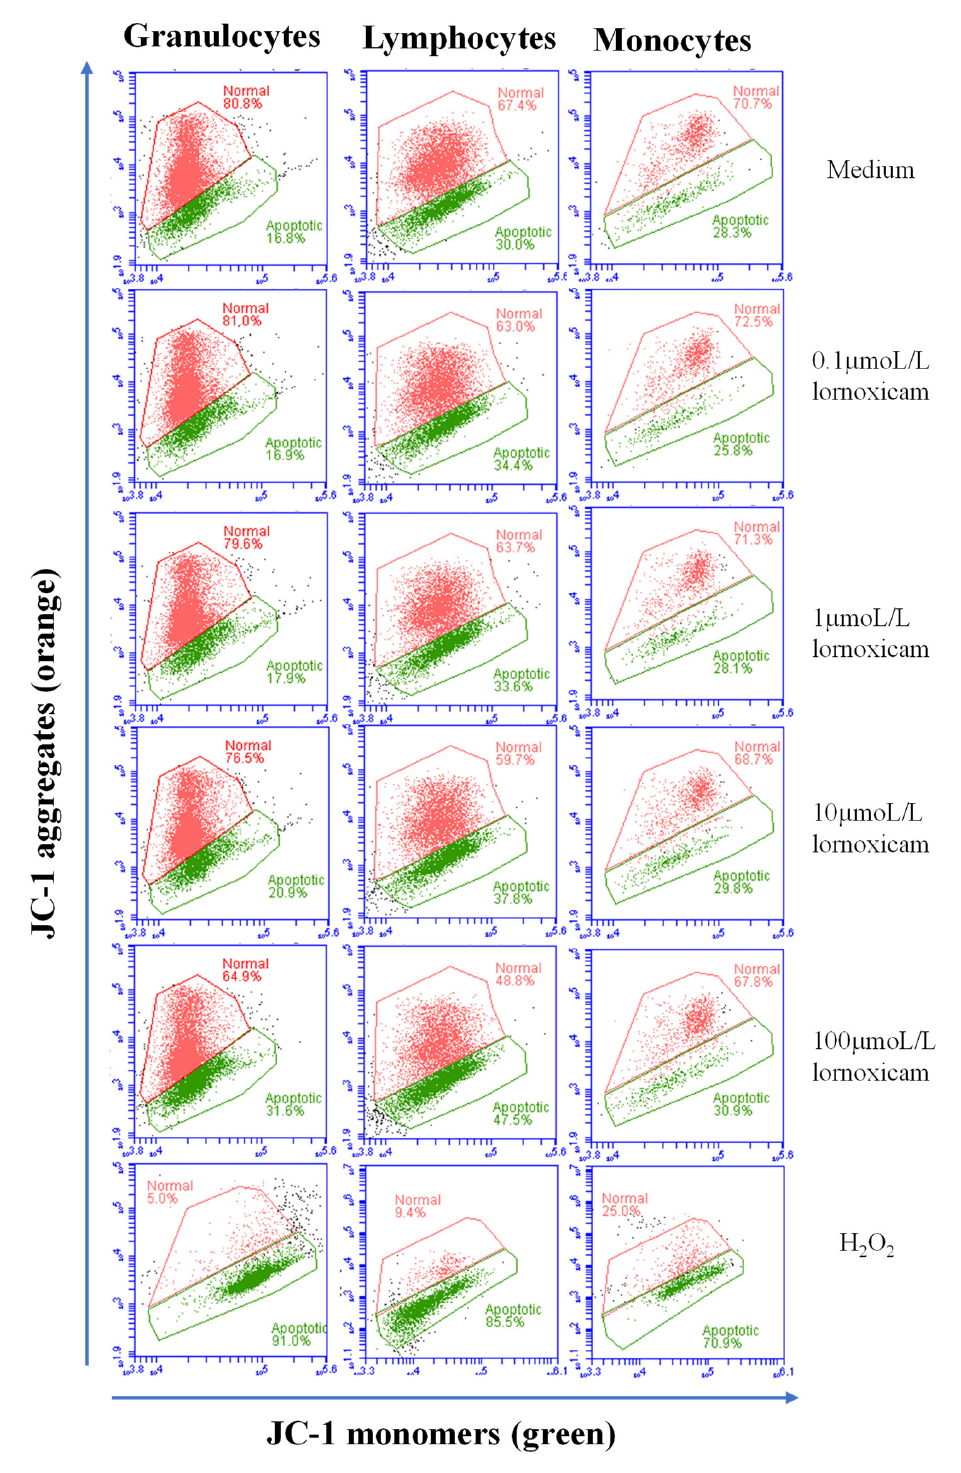
Figure 7. Analysis of leukocytes cell apoptosis using flow cytometry. Leukocytes were loaded with the JC-1 dye and the cell populations of granulocytes, lymphocytes, and monocytes were identified within singular cells based on cell type-specific FSC and SSC properties. The percentage of cells with orange JC-1 aggregates (non-apoptotic cells with increased fluorescence in FL-2) and cells with green JC-1 monomers (apoptotic cells with increased fluorescence in FL-1) were estimated for cells in medium and those collected from blood incubated with lornoxicam in vitro. Hydrogen peroxide (H 2 O 2 ) has been used to establish a positive control of apoptosis.